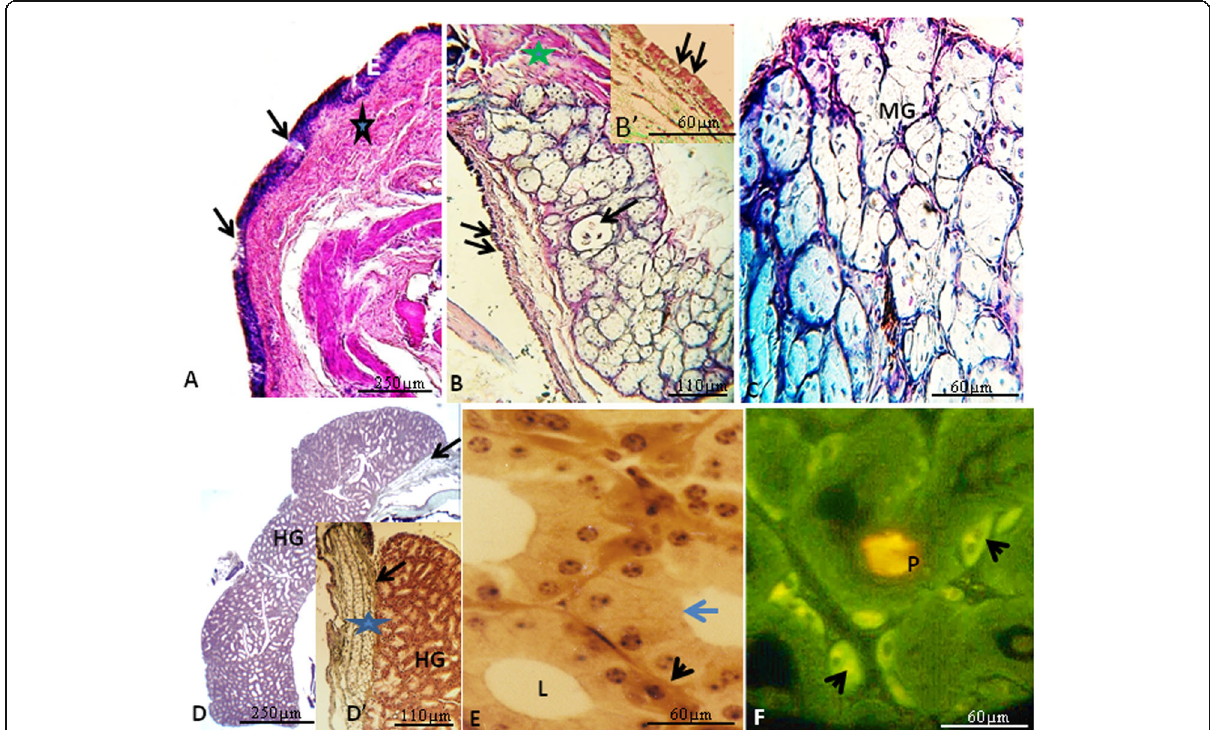
Fig. 2 (A) Light micrograph of gerbil bulbar conjunctiva: stratified epithelium (E) with clusters of goblet cells (arrows) and lamina propria (asterisk). H/E stain. (B) Meibomian glands embedded within the tarsal plate, central duct (arrow), palpebral conjunctiva (double arrow), and Muller muscle (asterisk). H/E stain; (B ’ ) inset box, goblet cells (double arrow) interspersed amongst epithelial columnar prismatic cells of palpebral surface. Masson ’ s trichrome stain. (C) A portion of Meibomian glands (MG) displaying the acinar cells entirely full by lipid droplets. H/E stain. (D) A micrograph showing the Harderian gland (HG) and third eyelid (arrow) closely fastened. Masson ’ s trichrome stain. (D ’ ) inset box, the presence of central hyalin cartilaginous tissue (arrow). Van Gieson stain. (E, F) Sections of HG, two secretory cells form the tubuloalveoli. (E) Pyramidal cells (arrowhead), prismatic cells (blue arrow), lumen (L). Van Gieson stain. (F) Section under a fluorescence microscope showing porphyrin (P) and pyramidal cells (arrowhead)